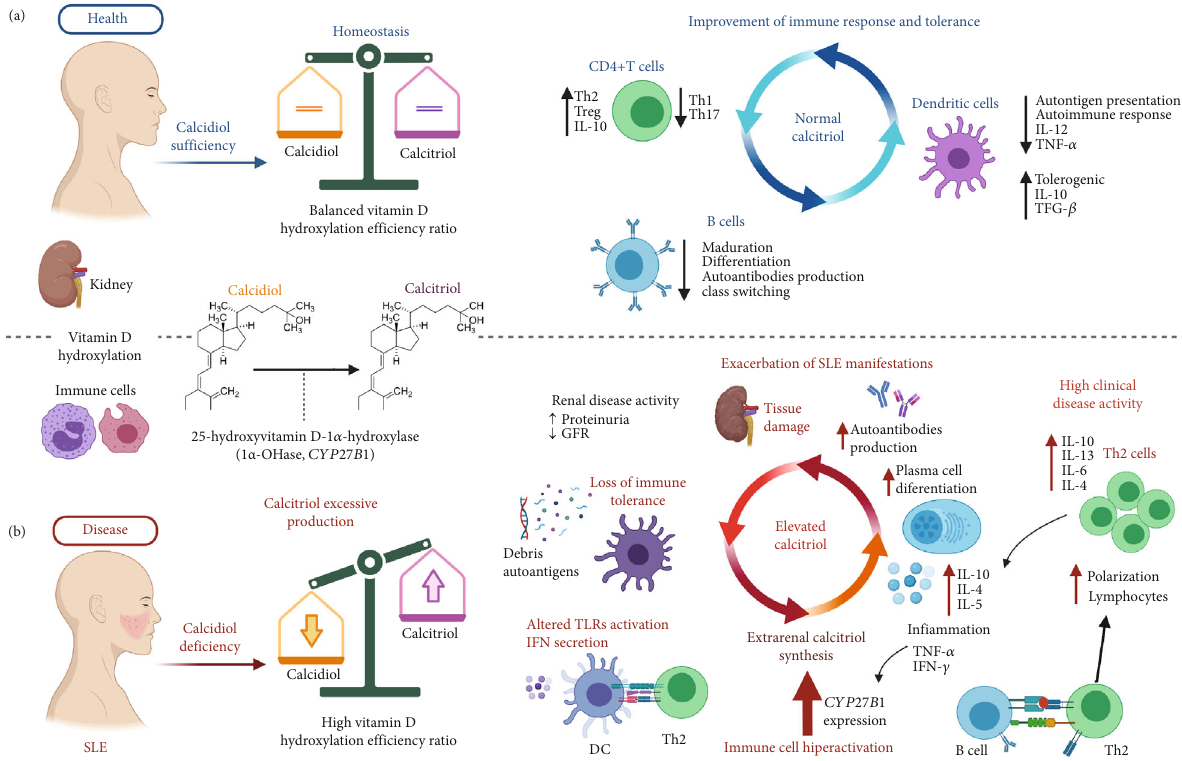
Figure 6: Biphasic e ff ect of calcitriol on health and autoimmunity. (a) In health, the bene fi cial e ff ect of calcitriol could be achieved at moderate concentrations presented in the calcidiol su ffi ciency status. Adequate concentrations of calcidiol and calcitriol (vitamin D su ffi ciency) allow adequate immunomodulation that improves the immune response and tolerance, favoring polarization towards the tolerogenic Th pro fi les, reducing the maturation of autoreactive B cells and the antigenic presentation of the dendritic cells, with an increase of IL-10 and TGF- β cytokines. (b) In SLE, lower calcidiol serum levels (vitamin D de fi ciency) increase the vitamin D hydroxylation e ffi ciency ratio and the extrarenal calcitriol synthesis; this event may occur due to a compensatory mechanism where